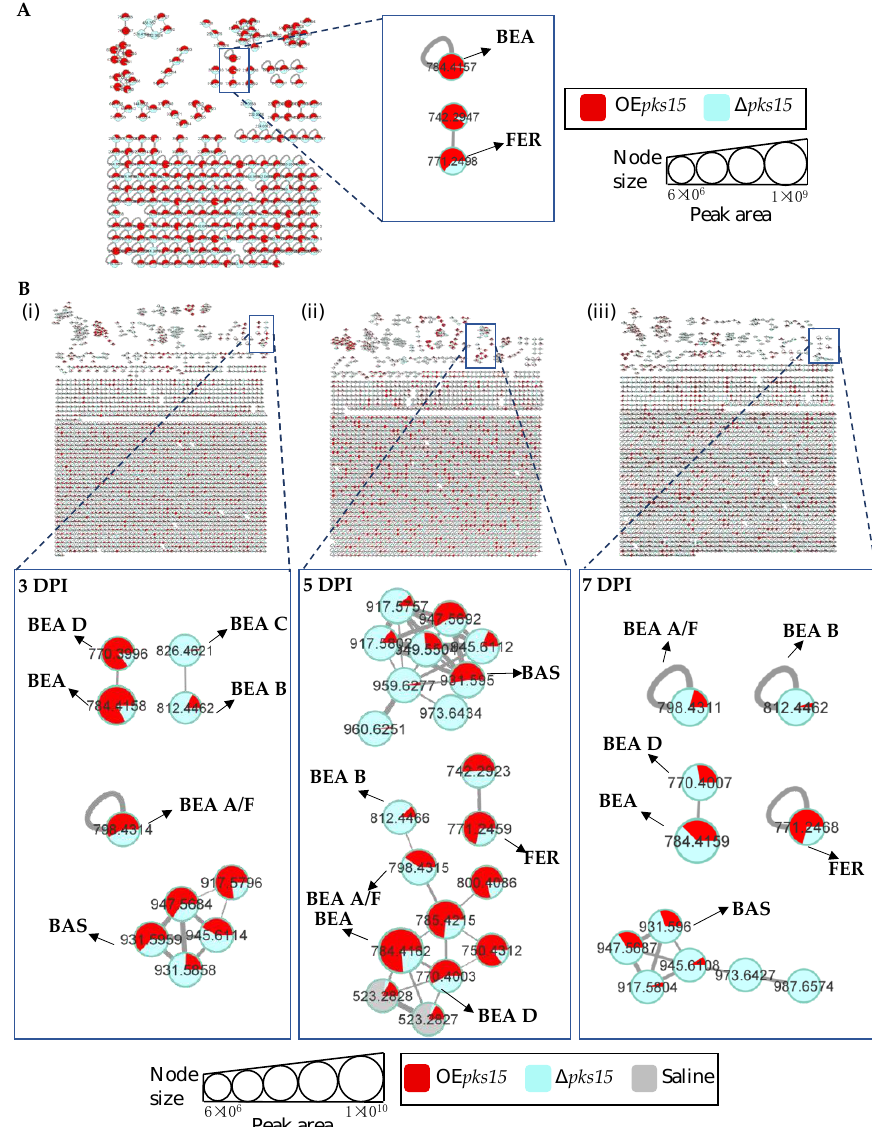
Figure 5. ( A ) Molecular networking of classified insect - virulence metabolites and a siderophore from OE pks15 ( red ) and Δ pks15 mutant ( light blue ) strains in culture identified beauvericin ( BEA ) and ferricrocin ( FER ). ( B ) Molecular networking of classified compounds from OE pks15 ( red ) and Δ pks15 mutant ( light blue ) strains in vivo at early - stage infection ( 3 DPI ) for live larvae ( i ) , mid - stage infection ( 5 DPI ) for dead larvae ( ii ) , and late - stage infection ( 7 DPI ) for cadavers covered with fungal hyphae ( iii ) identified beauvericin ( BEA ) , beauvericin A / F ( BEA A / F ) , beauvericin B ( BEA B ) , beauvericin C ( BEA C ) , beauvericin D ( BEA D ) , bassianolide ( BAS ) , and ferricrocin ( FER ). Saline - injected BAWs were used as controls ( gray ). Node sizes represent the sums of chromato- graphic peak areas, and pie charts indicate chromatographic peak-area proportions for the detected insect virulence factors.